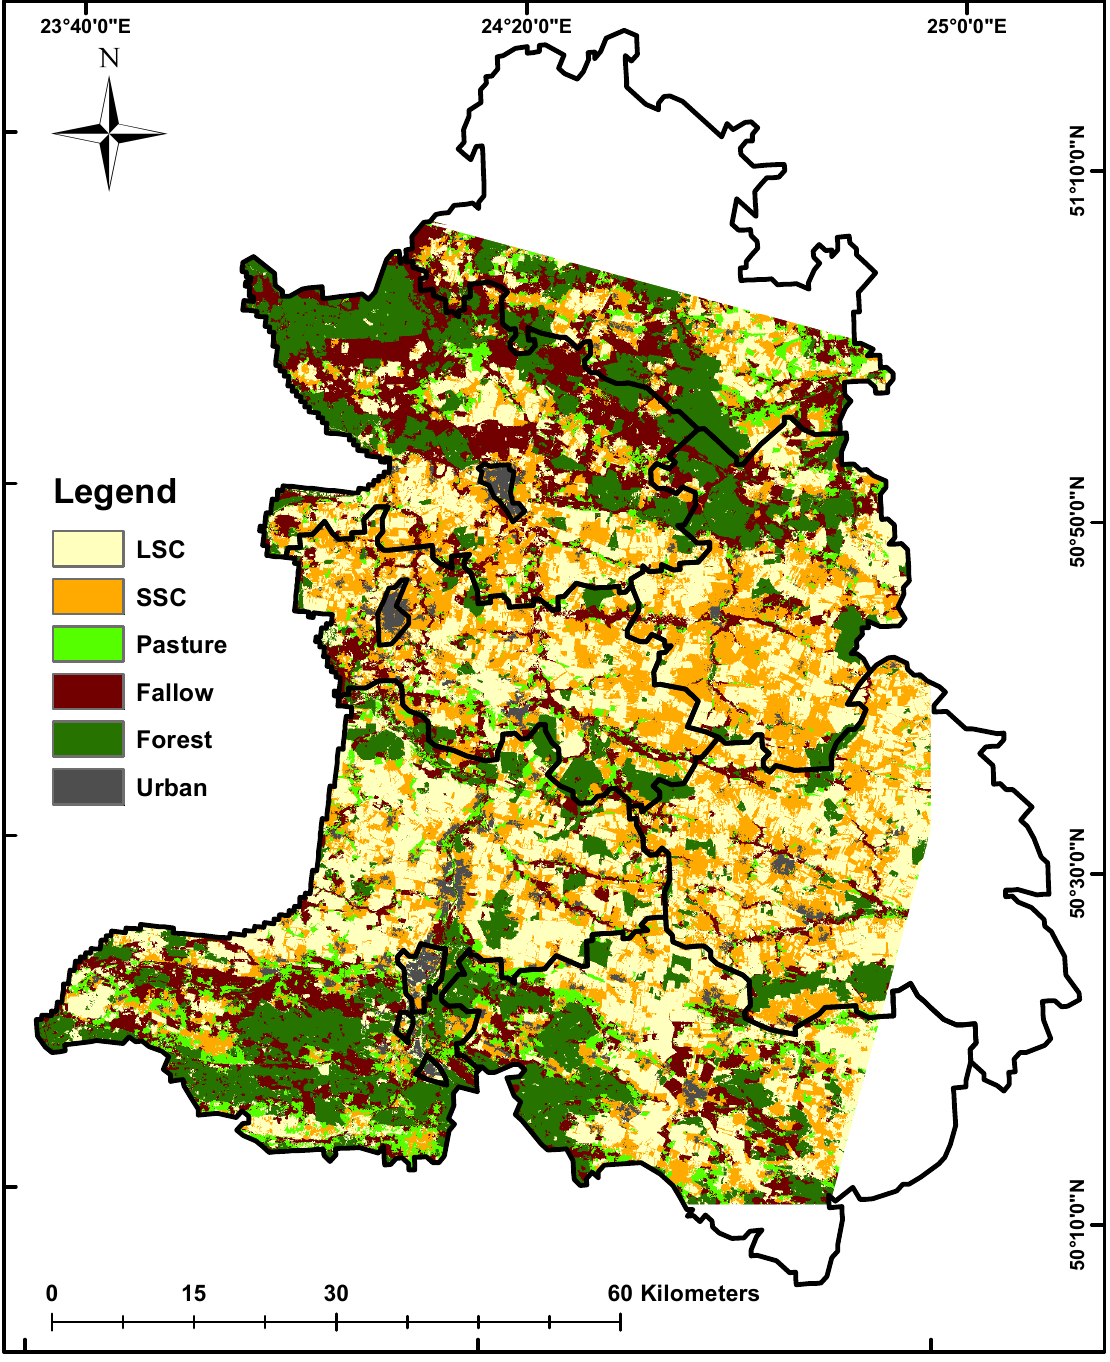
Figure 5. Agricultural land management regimes and additional land cover classes, mapped using the hierarchical classification based on Landsat and ERS data (LSC = large-scale cropland, SSC = small-scale